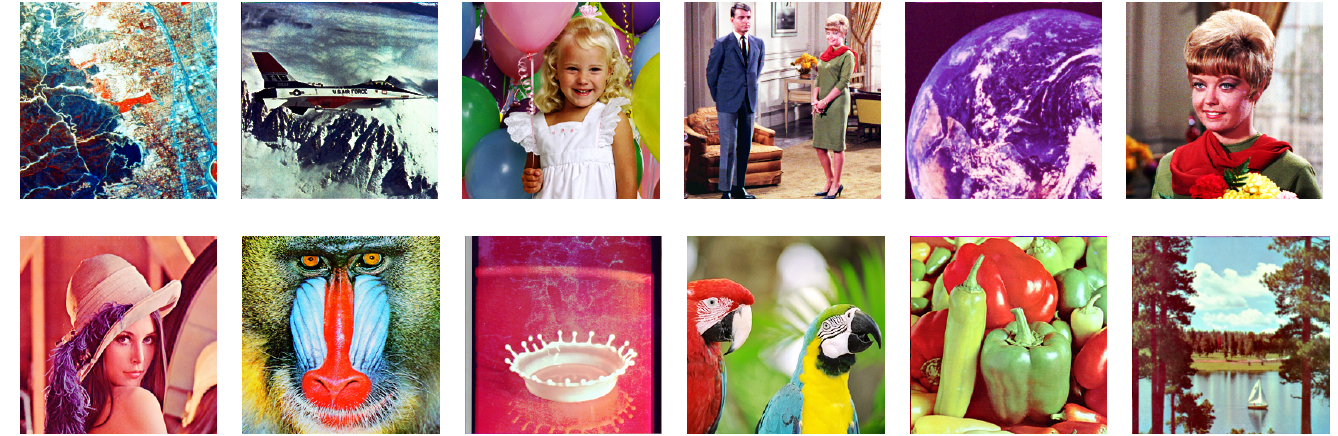
Figure 22. Results of the proposed exact histogram